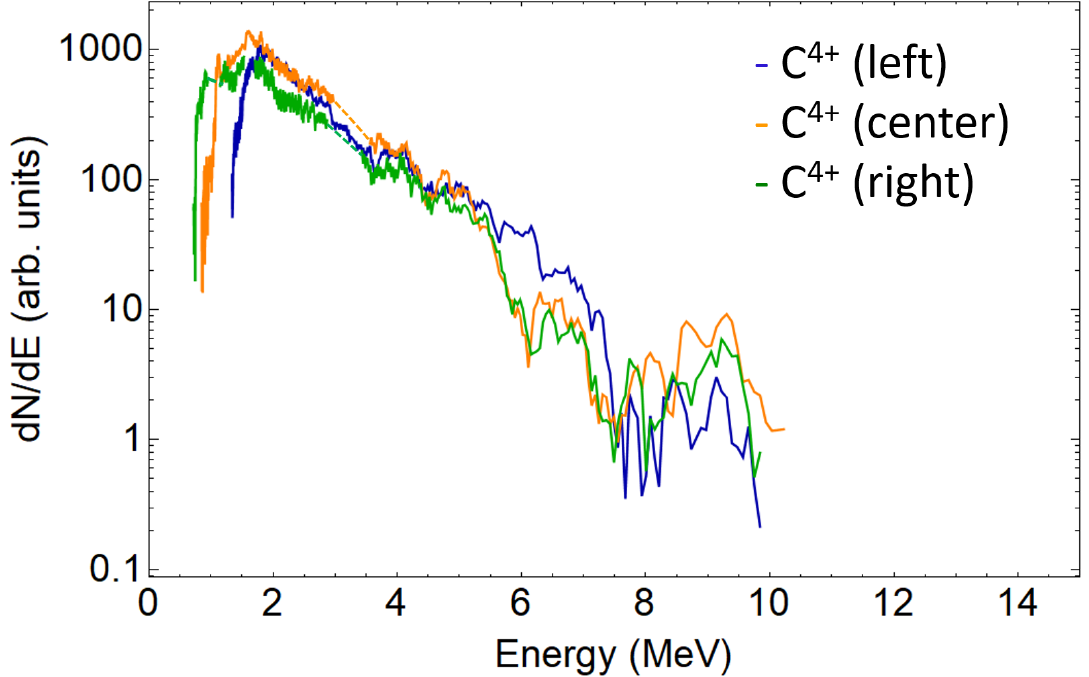
Figure 6. Left, center, and right C 4 + beamlets spectra in the logarithmic scale. Dashed lines show the reconstructed spectrum